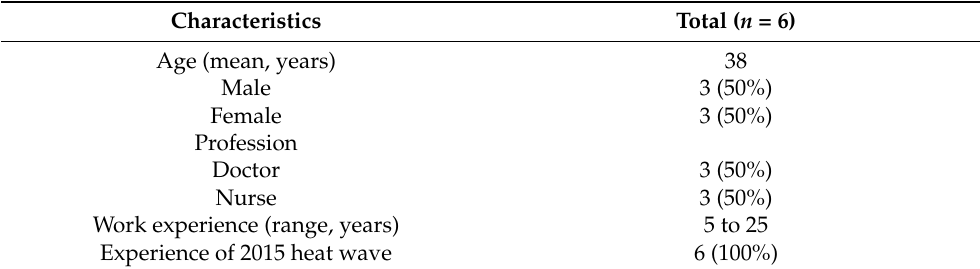
Table 2. Demographic characteristics of the IDI participants.